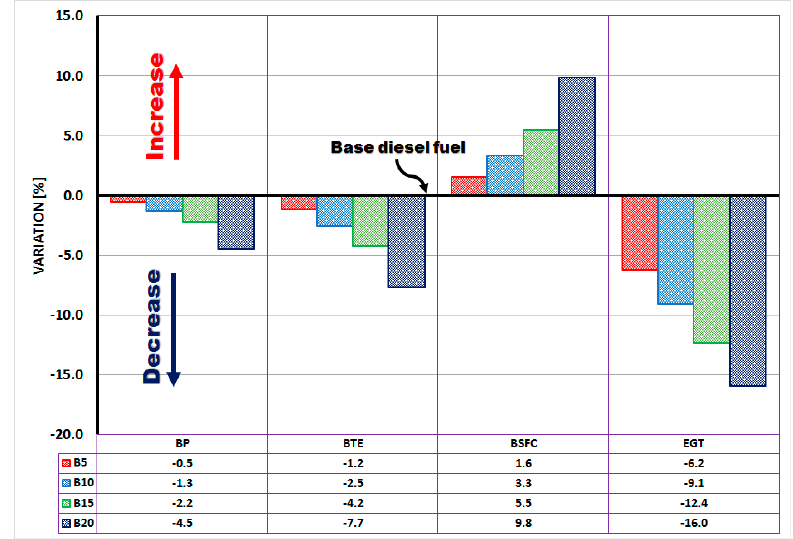
Figure 6. DSO biodiesel engine performance metrics averaged over all speeds and loads and normalized against baseline petrol diesel.